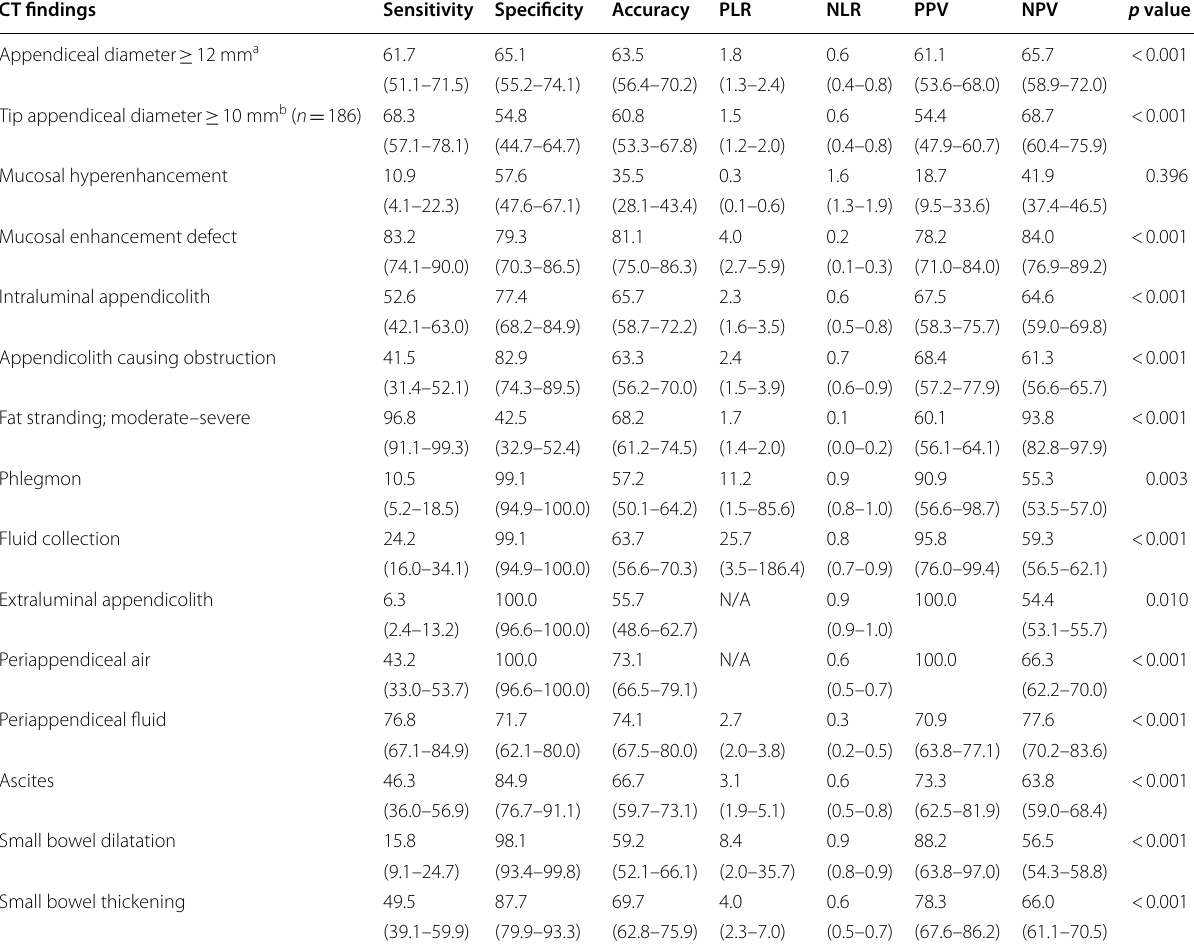
Table 4 Performance of each CT finding in differentiating complicated from uncomplicated